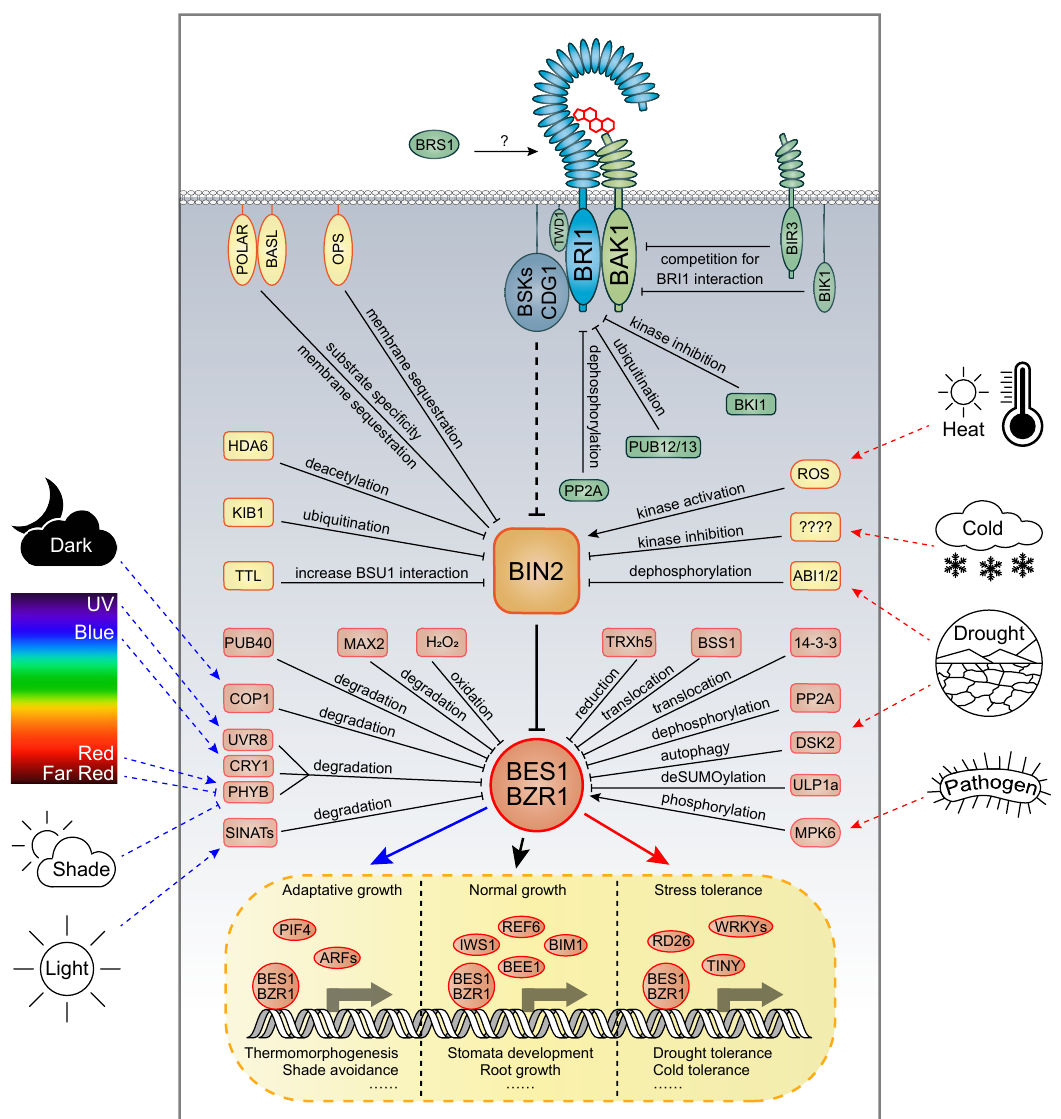
Figure 2. An integrated model for BR signal transduction and multiple levels of regulatory mechanisms in response to environmental changes. At the receptor level, the function of BRI1 is negatively regulated by PUB12 / 13, PP2A, BKI1, BIK1, and BIR3, and positively regulated by BRS1, TWD1, and BAK1. At the BIN2 level, the function of BIN2 is inhibited by OCTOPUS, POLAR, HDA6, KIB1, TTL, ABI1 / 2, and ROS. At the transcription level, the protein stability of BES1 and BZR1 is negatively regulated by MAX2, PUB40, COP1, SINATs, PHYB, CRY1, and UVR8. BES1 or BZR1 also acts synergistically of antagonistically with many other transcription factors to determine plant growth and stress tolerance. Blue arrows indicate adaptive growth, whereas red arrows represent stress tolerance. Lines with blunt ends represent